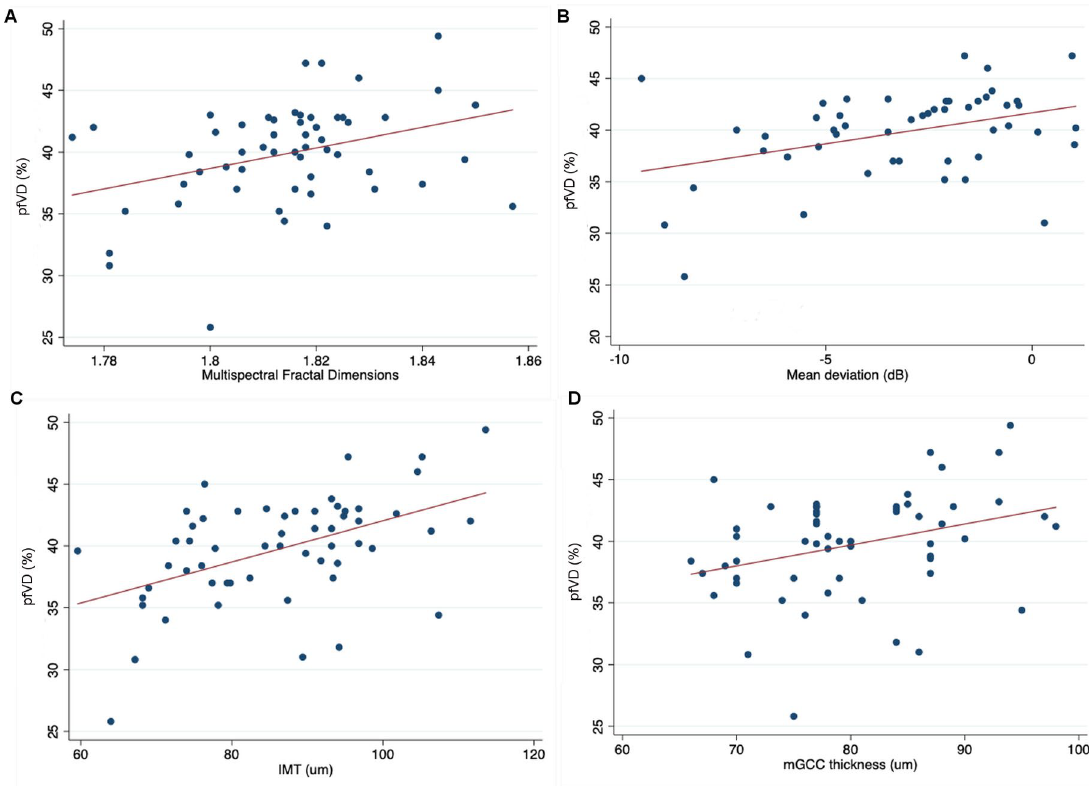
Figure 2. ( A ) Relationship between multispectral fractal dimensions and average pfVD (R 2 = 0.124, P = 0.008). ( B ) Relationship between MD and average pfVD (%) (R 2 = 0.136, P = 0.007). ( C ) Relationship between IMT and average pfVD (%) (R 2 = 0.237, P < 0.001). ( D ) Relationship between IMT and average pfVD (%) (R 2 = 0.104, P = 0.015).